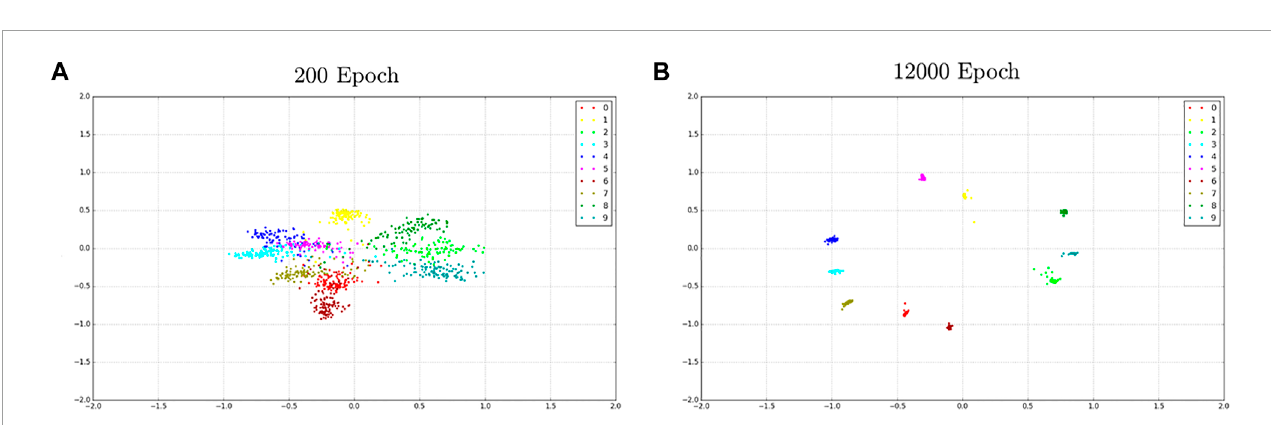
FIGURE 6 Distribution of the learned features under the joint supervision of the center-loss algorithm. Each color represents a total of nine different features from particular classes associated with a different identity. (A) shows the learning process after 200 epochs, while (B) depicts the learning process after 12,000 epochs. Notably, distances are normalized and each color represents a different